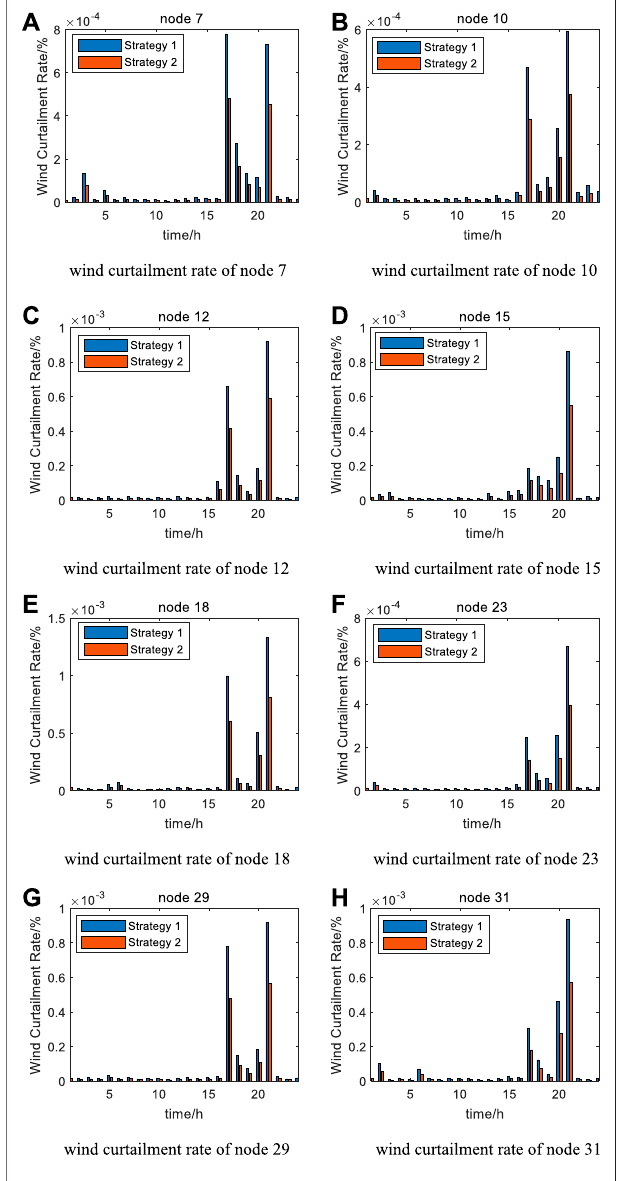
FIGURE6| wind curtailment ratesofstrategy1andstrategy2. (A) Wind curtailment rate of node 7. (B) Wind curtailment rate of node 10. (C) Wind curtailment rate of node 12. (D) Wind curtailment rate of node 15. (E) Wind curtailment rate of node 18. (F) Wind curtailment rate of node 23. (G) Wind curtailment rate of node 29. (H) Wind curtailment rate of node